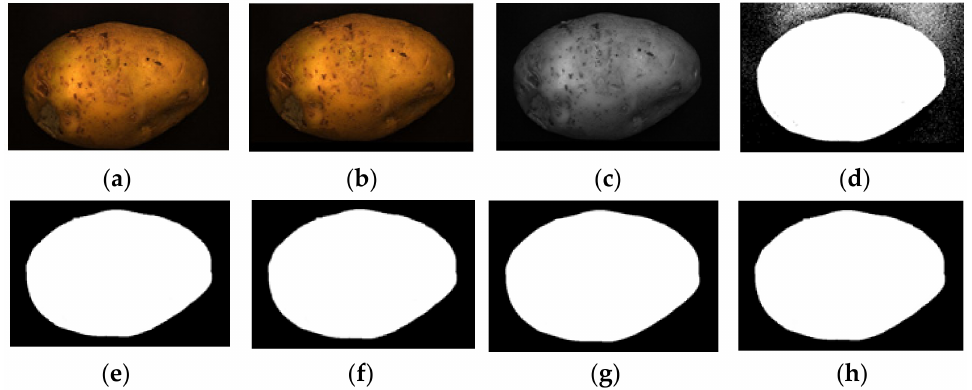
Figure 4. Image preprocessing results: ( a ) resizing, ( b ) translation, ( c ) graying, ( d ) binarization, ( e ) morphological filtering, ( f ) Gaussian filtering, ( g ) media filtering, and ( h ) bilateral